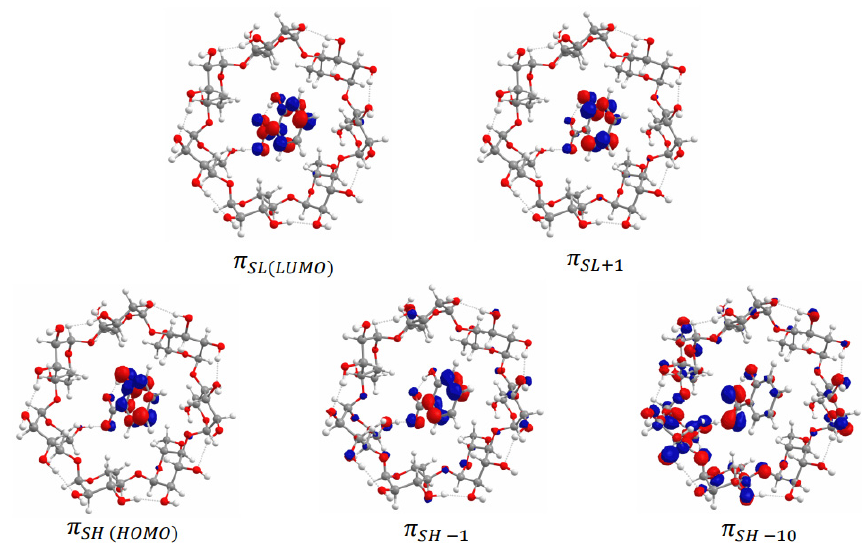
Figure 7. Molecular orbitals of the β -CD-NaSal complex.